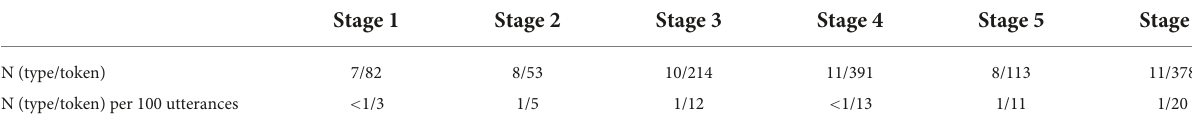
TABLE 7 The number of nominalizers (N type/token) and the number of nominalizers per 100 utterances (N type/token), by stage. Stage 1 Stage